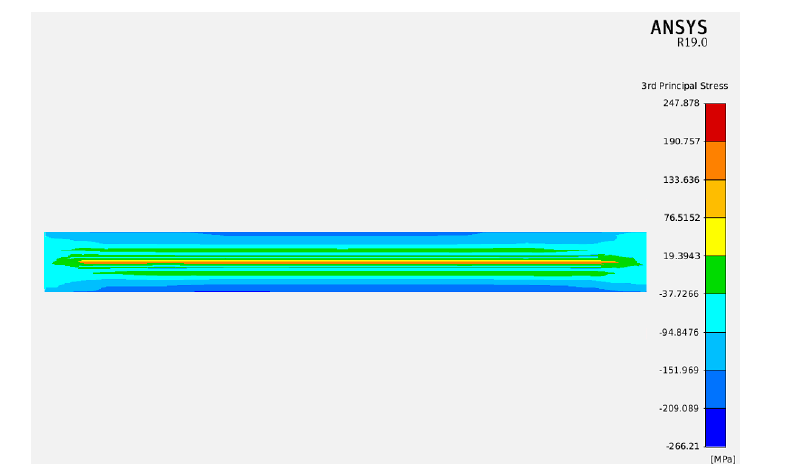
Figure 5. The residual stresses on the transversal section view of the 6061 aluminium alloy plate after the quenching process numerical values. Di ff erent values were obtained on the bottom of the plate vs the top of the plate.